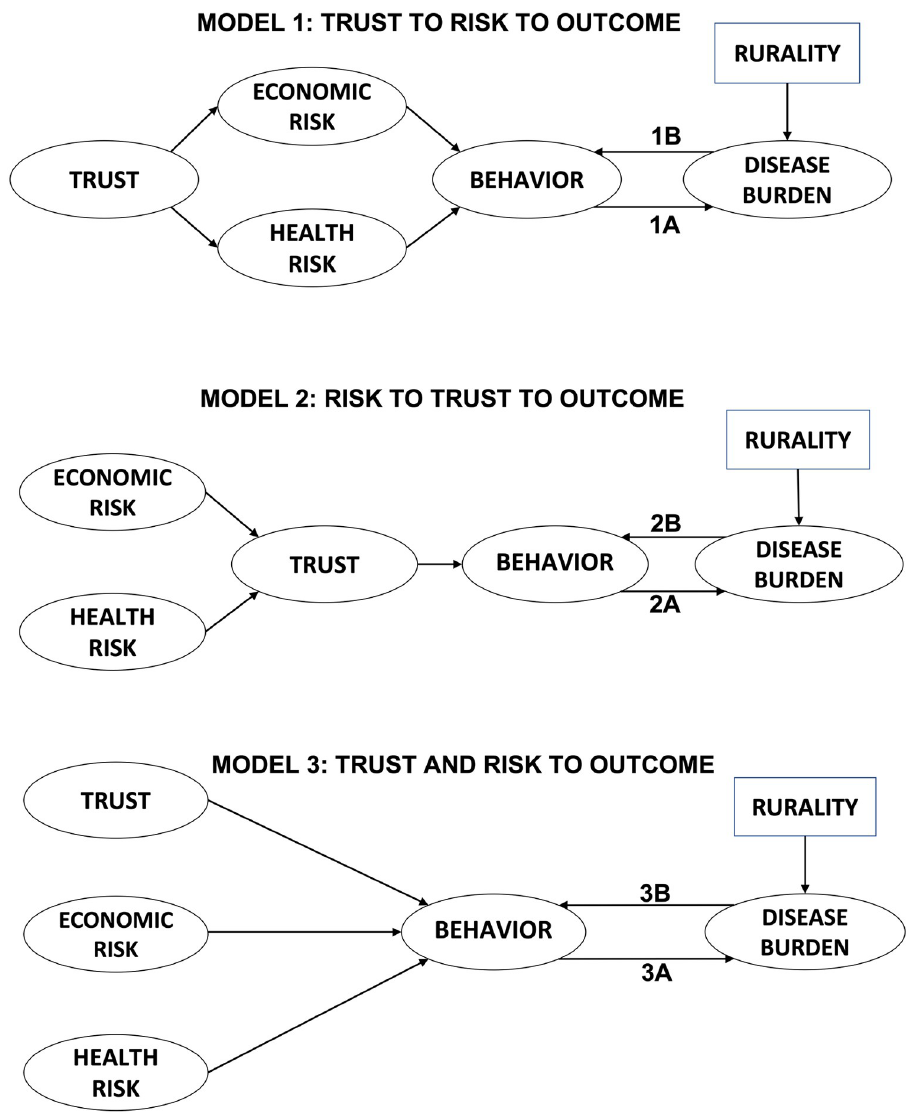
Fig 1. Hypothesized conceptual models. We tested several hypotheses about the interplay between trust, risk perception, behavioral intention, and COVID-19 disease burden. Each path diagram shows the hypothesized causal relationships between our measured variables. Latent variables are shown in ovals; exogenous variables are shown in rectangles. Structural equation modeling (SEM) was used to assess which model was best supported by our survey